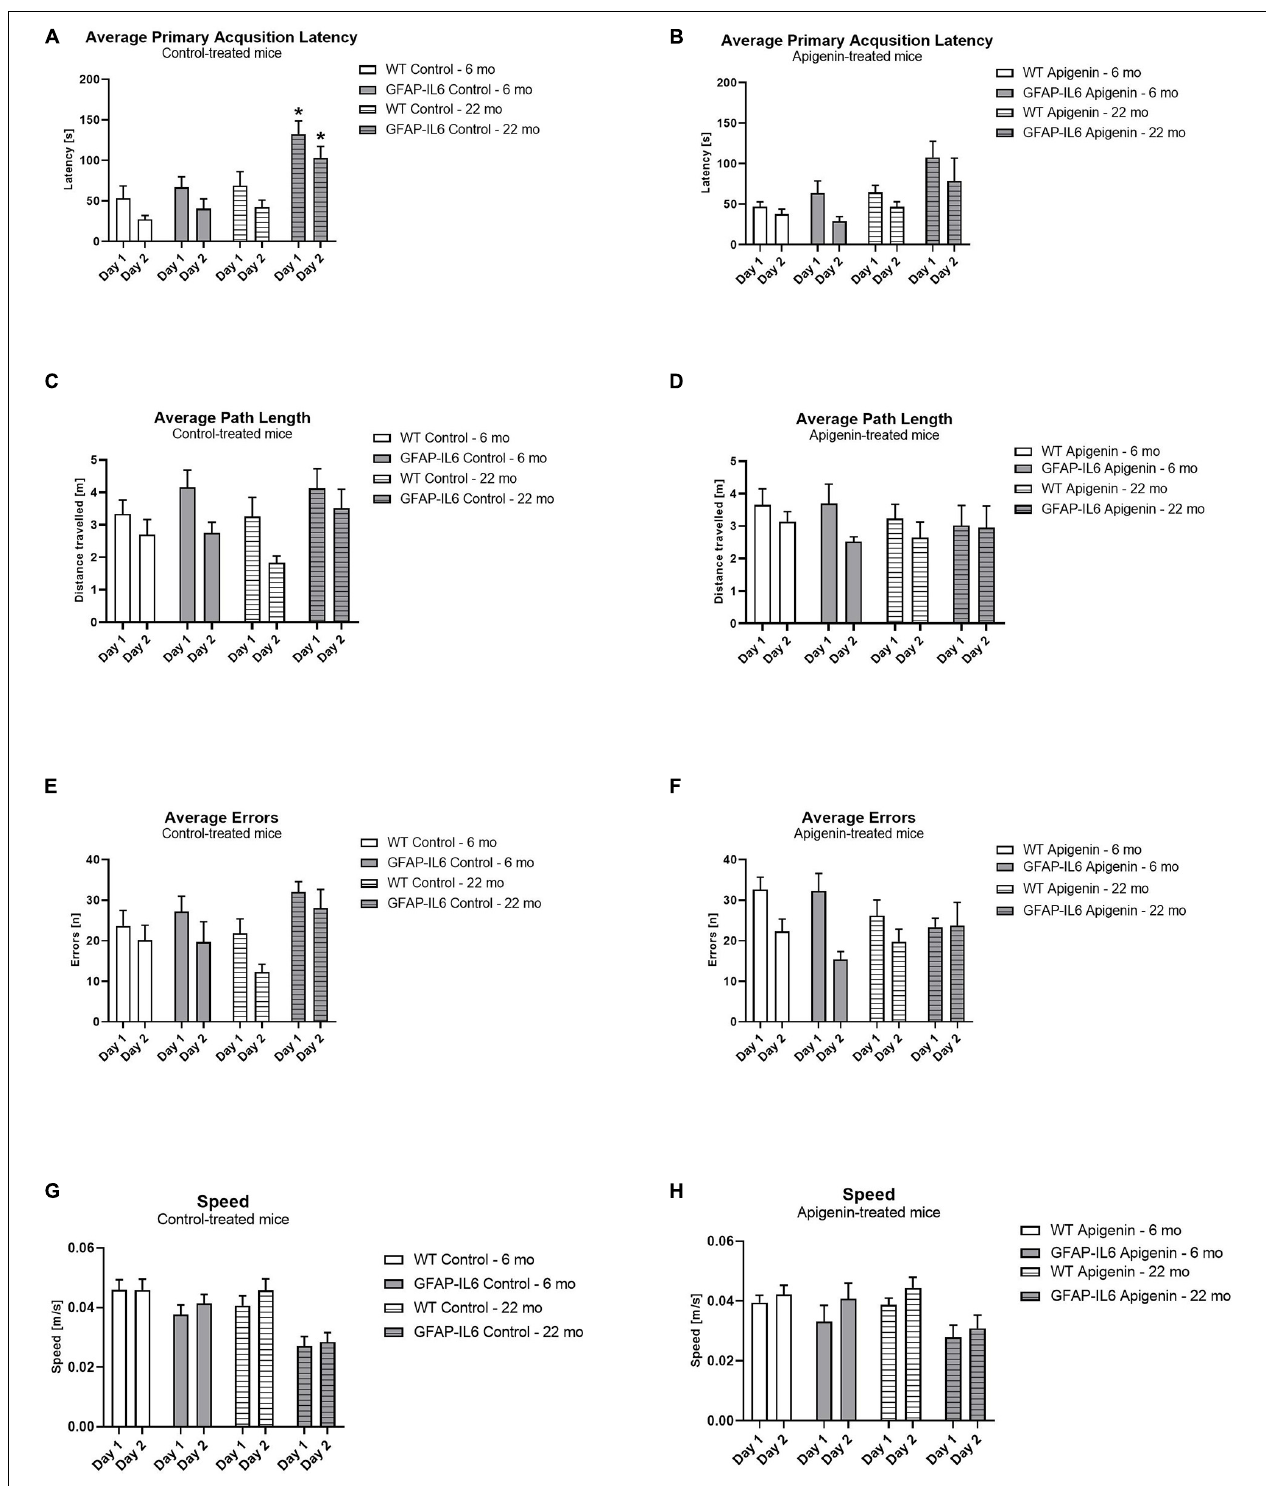
FIGURE 1 | (A–H) Effect of age and apigenin diet on Barnes Maze Acquisition in WT and GFAP-IL6 mice. Primary Acquisition latency (s) is presented for standard diet-fed mice in (A) and apigenin-fed mice in (B) , and Average Path length (m) is shown for standard diet-fed mice in (C) and apigenin-fed mice in (D) . Average Errors (n) is displayed for standard diet-fed mice in (E) and apigenin-fed mice in (F) , while average speed (m/s) is presented for standard diet-fed mice in (G) and apigenin-fed mice in (H) . Data analyzed with four-way ANOVA, followed by Bonferroni post hoc tests. Post hoc effects of “genotype” within the same age and treatment group are indicated by stars (* p < 0.05). Data presented as means ± SEM.